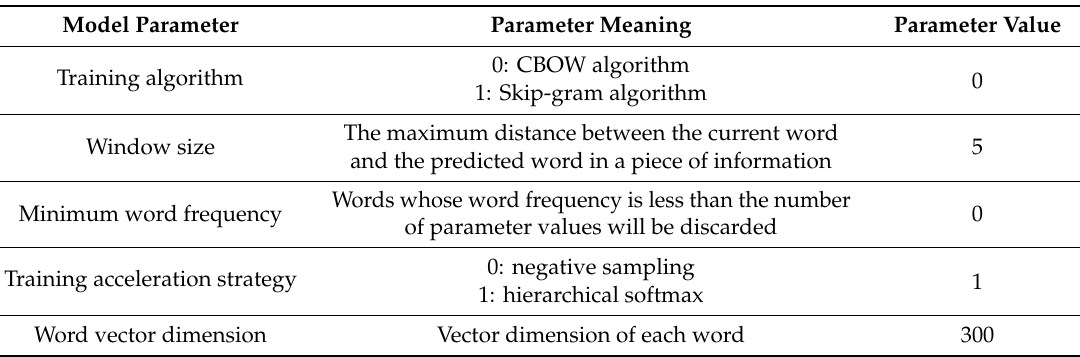
Table 3. Key parameters of the Word2vec